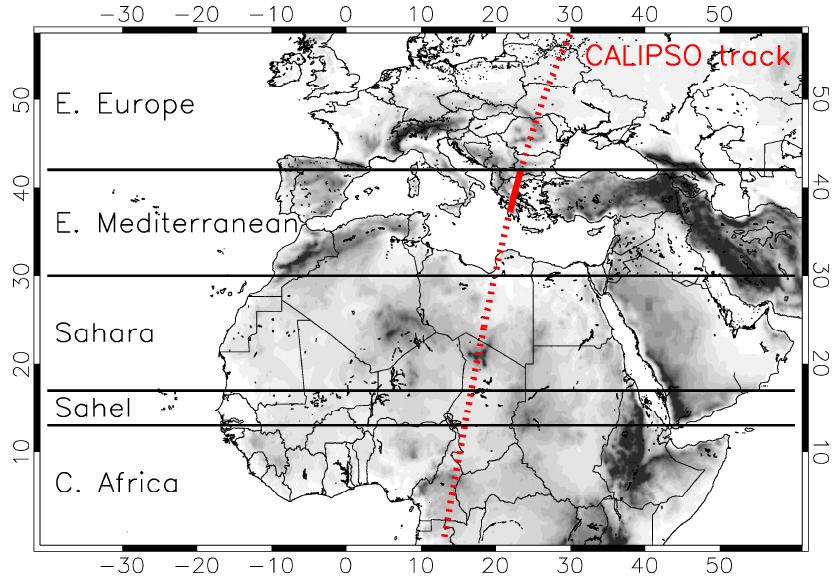
Figure 2. CALIPSO track (dotted red line) along with different areas of interest. The track over the greater Thessaloniki area is marked with a solid red line.